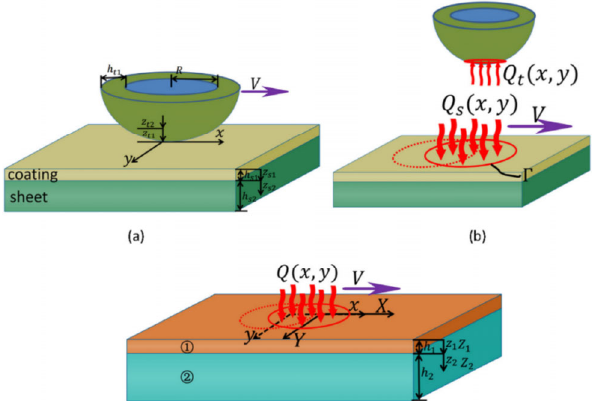
Fig. 71 Heat transfer at the tool tip–sheet interface. (a) A tool tip moving on a thin sheet with constant velocity V along the x -direction; (b) heat generated in the interface between the tool tip and sheet surfaces and its partition, note that the sheet is subjected to a moving heat source; and (c) problem generalized to a coating– substrate system under a moving surface flux, Q [909]. Reproduced with permission from Ref. [909], © Elsevier Ltd.,